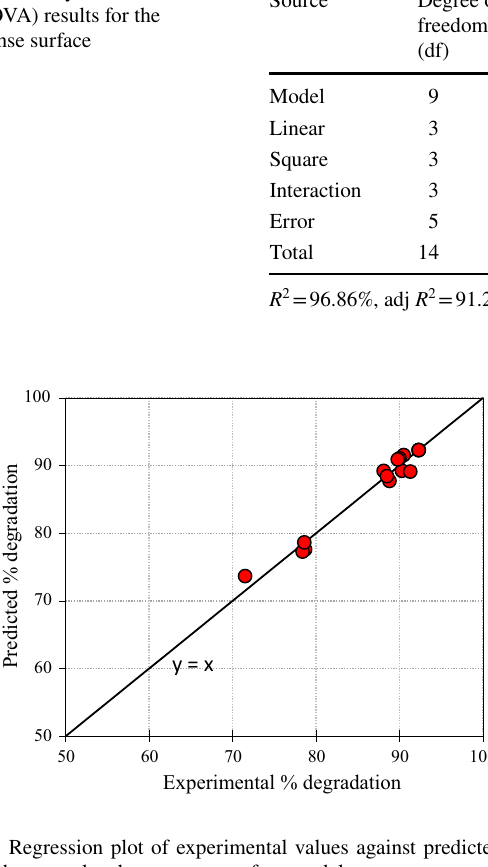
Fig. 7 Regression plot of experimental values against predicted data from the second-order response surface